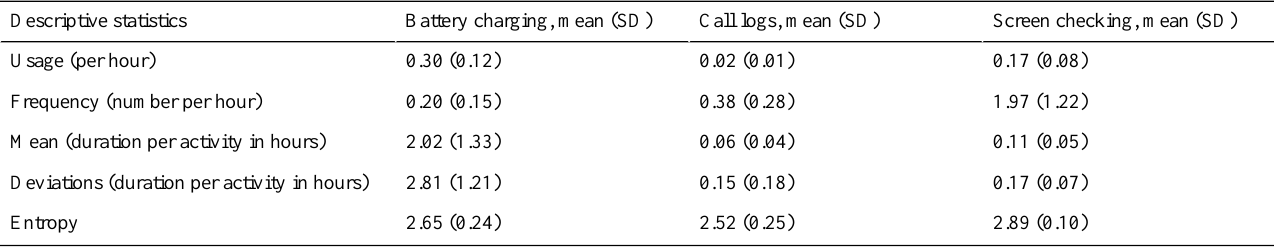
Table 1. Descriptive statistics of mobile sensor data and features.